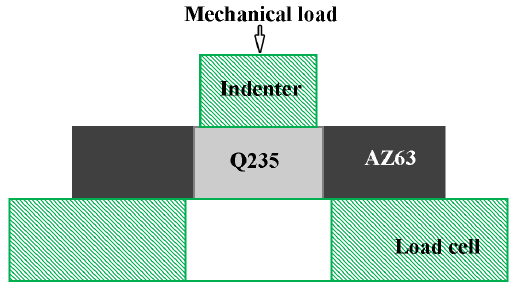
Figure 2. Schematic diagram of the push-out test. The microhardnesses of the interface for the AZ63 and Q235 were measured by